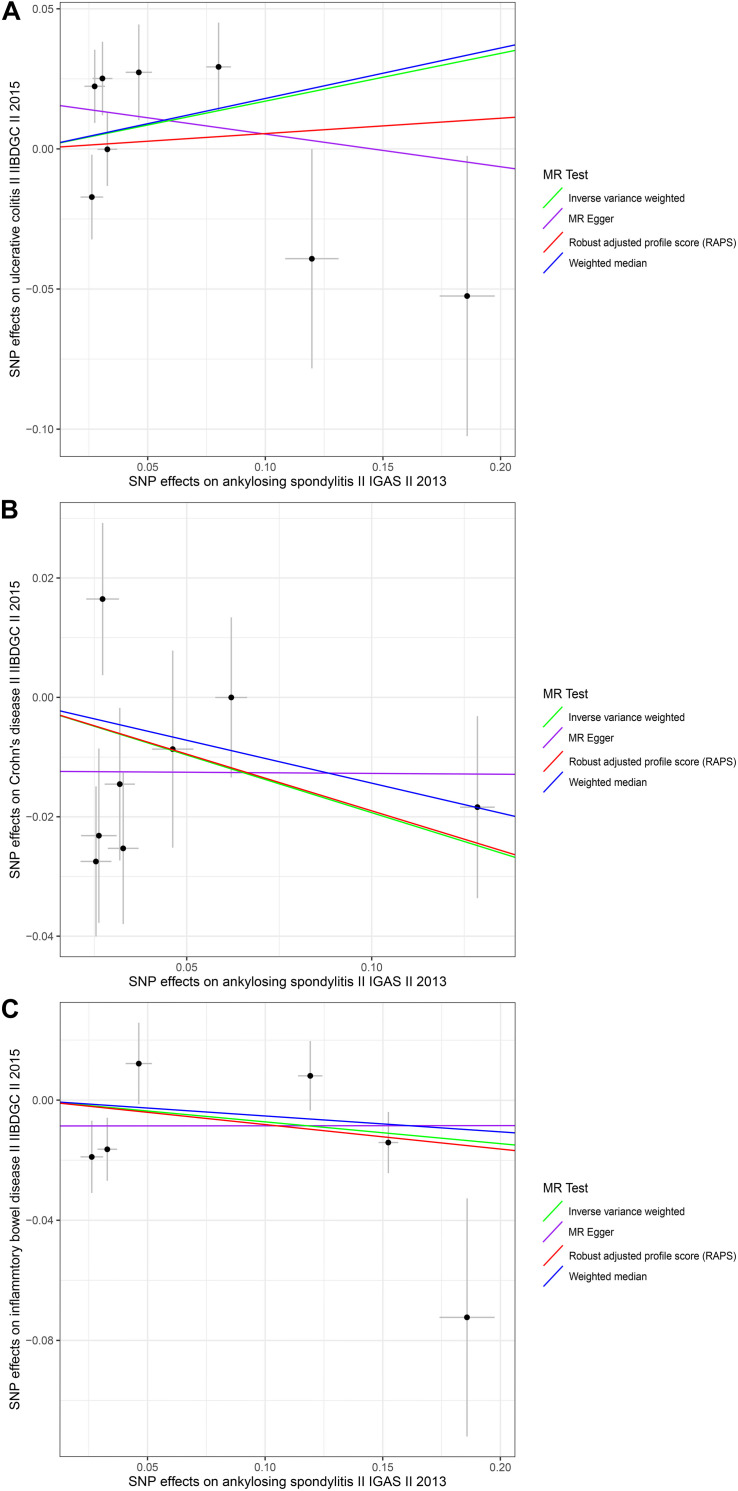
Scatter plots of the genetic associations with ankylosing spondylitis against inflammatory bowel disease risk using different MR methods. (A) Ankylosing spondylitis against ulcerative colitis risk; (B) ankylosing spondylitis against Crohn’s disease risk; and (C) ankylosing spondylitis against inflammatory bowel disease risk. The slopes of each line represent the causal association for each method. The green line represents the inverse variance weighted estimate, the purple line represents the MR-Egger estimate, the red line represents the MR.RAPS estimate, and the blue line represents the weighted median estimate.